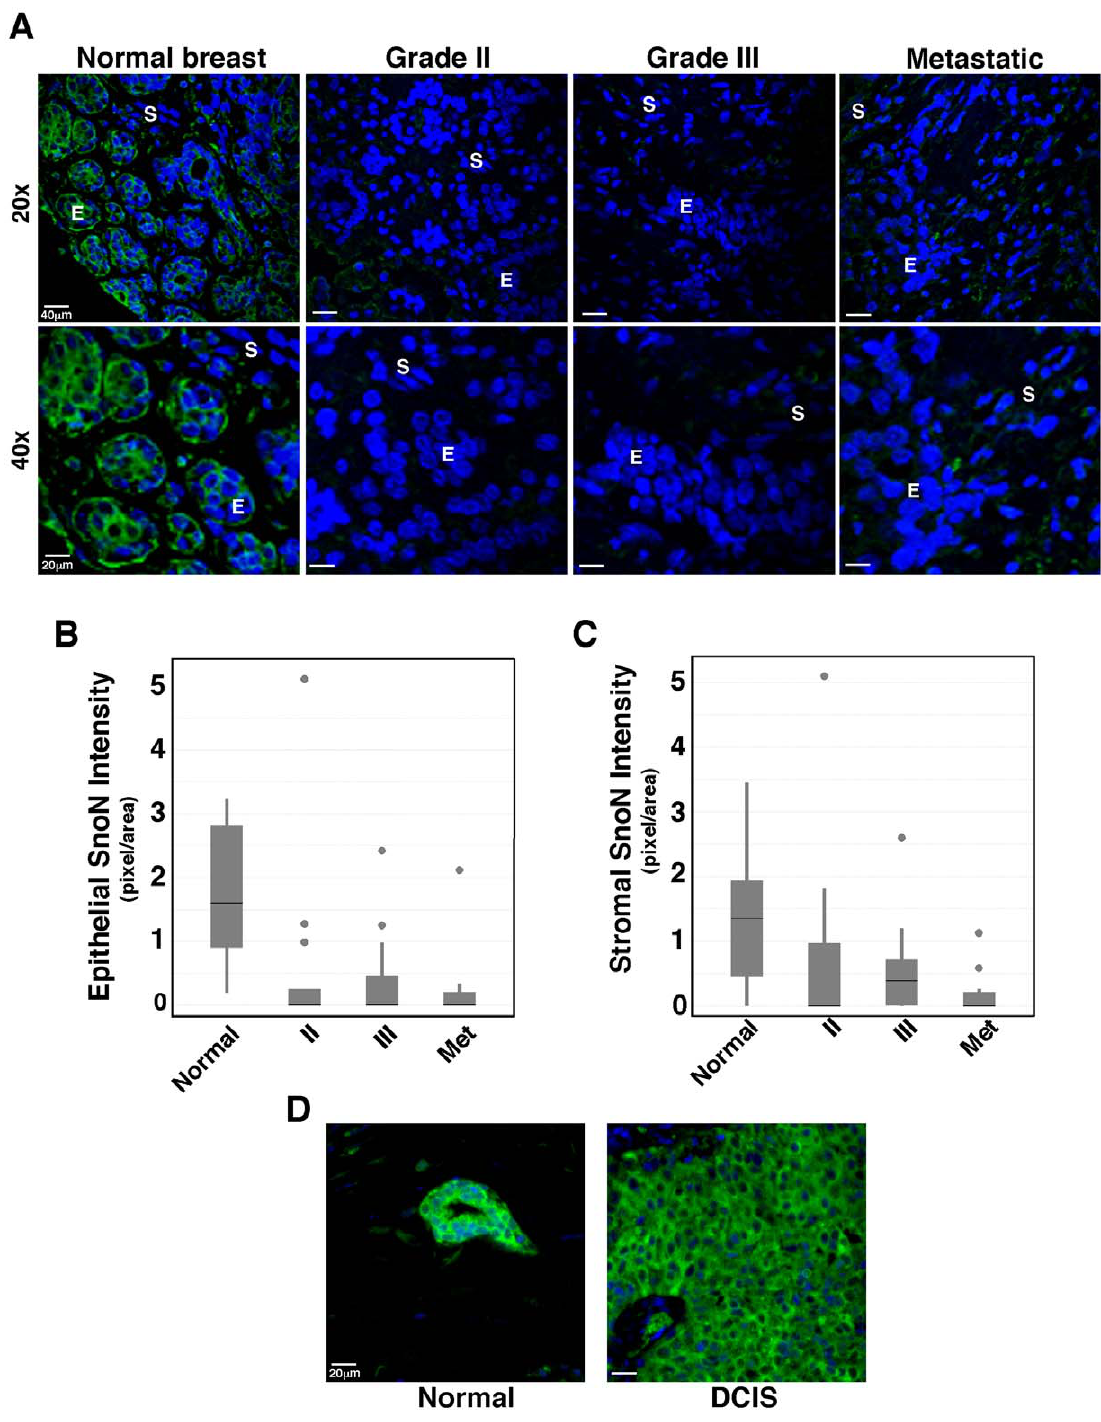
Figure 5. SnoN expression is reduced in breast ductal adenocarcinoma. A, Representative SnoN expression in the normal and breast ductal adenocarcinoma samples at 20X (top) or 40X (bottom) magnifications. E: epithelium; S: stroma. Green: SnoN; blue, DAPI. B, SnoN staining in normal (n=6, mean=1.59) and breast tumor epithelial cells of grade II (n=9 for IIA and n=3 for IIB, mean=0), grade III (n=10 for IIIA and n=5 for IIIC, mean=0), and metastatic samples (n=10, mean=0). The decreases of SnoN expression in tumor samples in comparison to normal tissues has a p value of 0.0966 for grade II, 0.0430 for grade III, and 0.0321 for the metastatic samples. C, SnoN staining in stromal cells from normal (n=6, mean=1.35) and breast tumor samples of grade II (n=9 for IIA and n=3 for IIB, mean=0), grade III (n=10 for IIIA and n=5 for IIIC, mean=0.38), and metastatic samples (n=10, mean=0). The p values for each tumor/normal comparison was 0.3340 for grade II, 0.1647 for grade III, and 0.0695 for the metastatic samples. D, Representative SnoN expression from a normal breast section and DCIS section taken from the same patient. Green: SnoN; blue, DAPI.